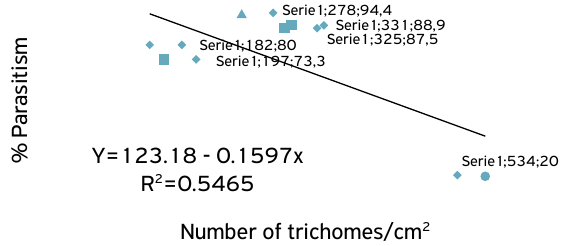
Figure 1. Correlation between the number of trichomes/cm 2 and parasitism of Liriomyza sativae larvae by Opius scabriventris , on different melon